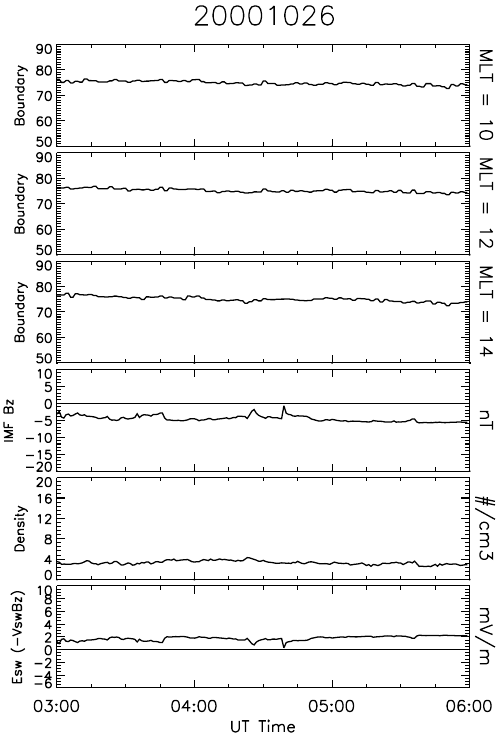
Fig. 9. A stack plot of the dayside boundaries for the SMC on 26 October 2006. The set up is the same as Fig.